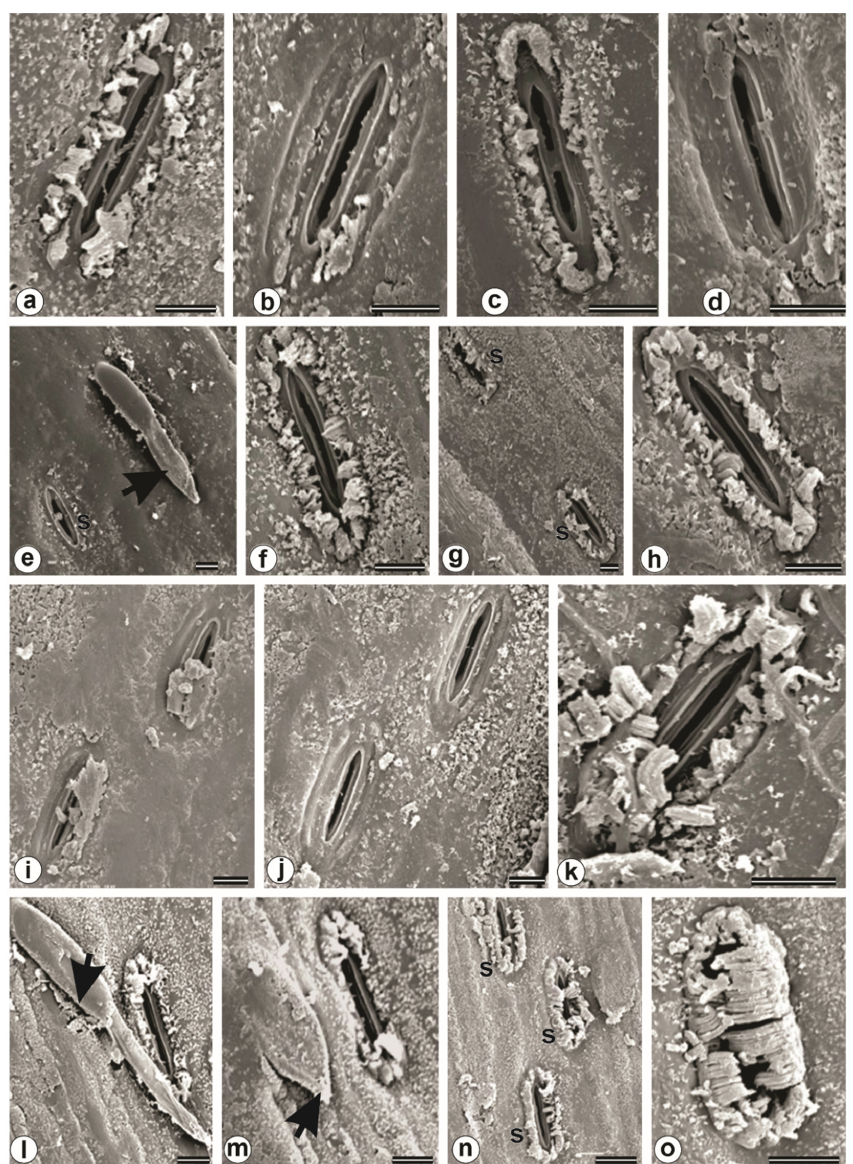
Figure 10. SEM micrograph of adaxial epidermis in four varieties (RB92579, ( a – d ); RB867515, ( e – h ); RB855536, ( i – k ); and RB72454, ( l – o )) of sugarcane. The leaf fragments were collected in rainy season ( a , b , e , f , i , j , l , m ) and dry season ( c , d , g , h , k , m , o ) at 8:00 to 10:00 h. Scale = 10 µ m. In ( e , l , m ) the arrow points to the epidermal hair. s. denotes stomata. For more information, see Table